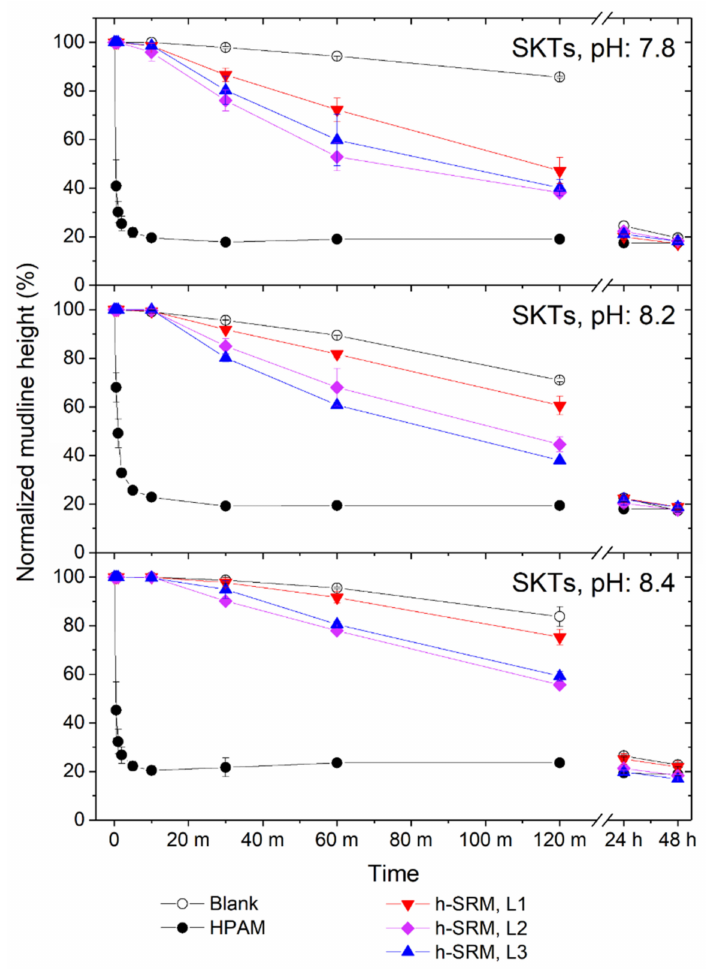
Figure 3. Mudline descending of SKTs, presented in form of Normalized mudline height over Time, with different initial pH: 7.8, 8.2, and 8.4 (from top to bottom). Tailings were treated with specified dosage of SRM-peptides. The blank control and the industrial control (HPAM; optimum dosage) were tested in parallel for comparison. The units “m” and “h” at the Time-axis correspond to min and hour, respectively; h-SRM refers to SRM-peptides at three dosage levels (L1–L3) from 10 kg to up to 30 kg per ton of kaolinite solids. Error bars represent the standard deviation of each experimental